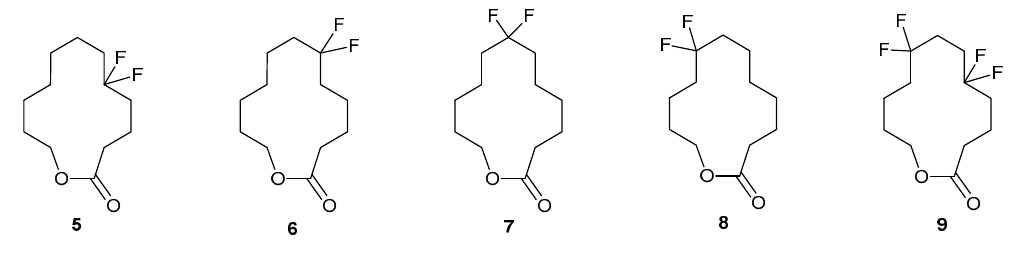
Figure 3. Fluorinated 12-dodecanolides.